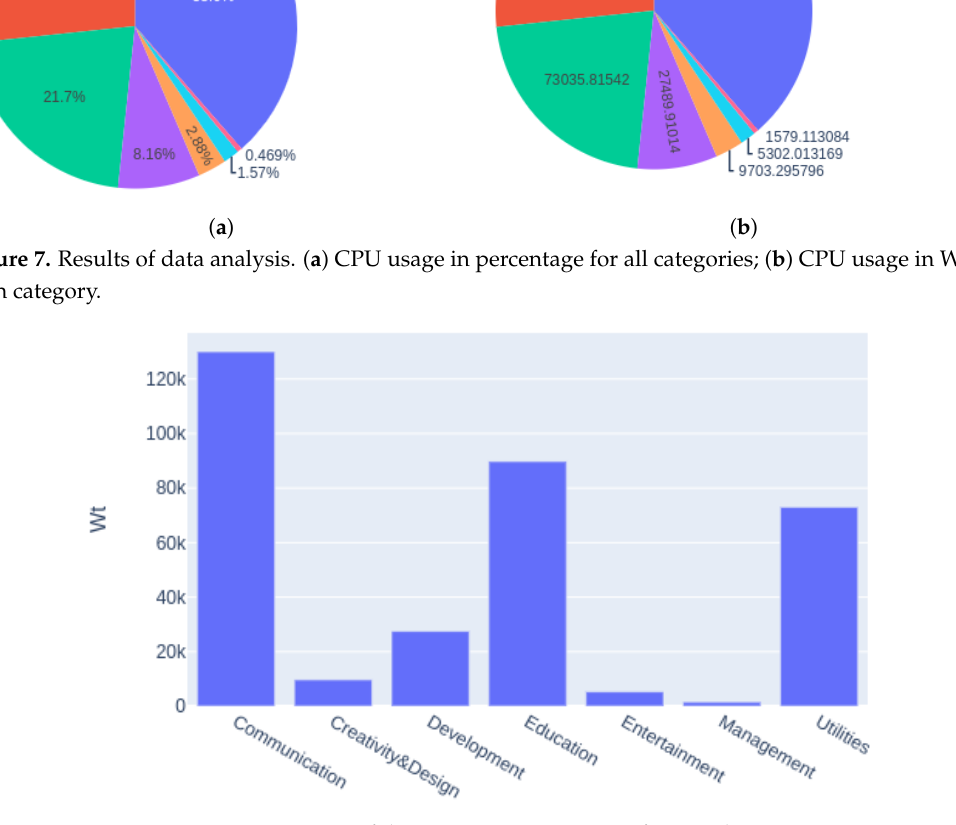
Figure 8. Representation of the energy consumption of particular